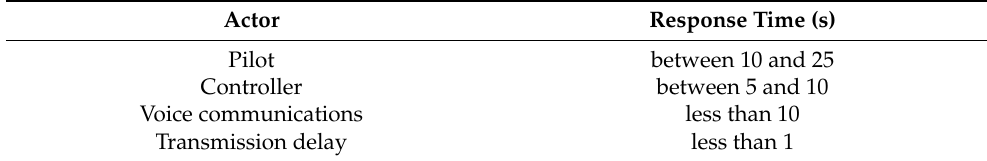
Table 5. Characteristic response times.